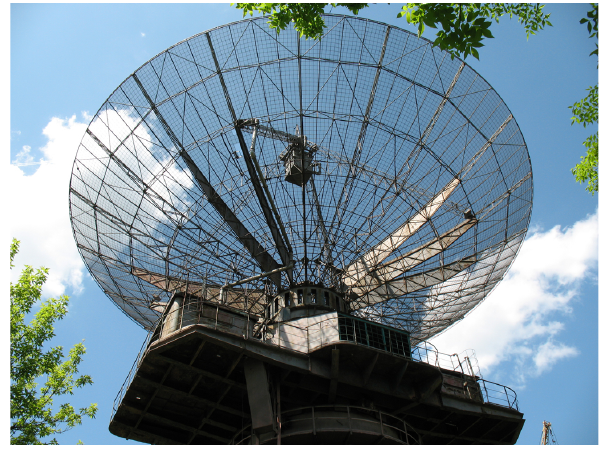
Figure 7. The fully steerable 25-m-diameter antenna.